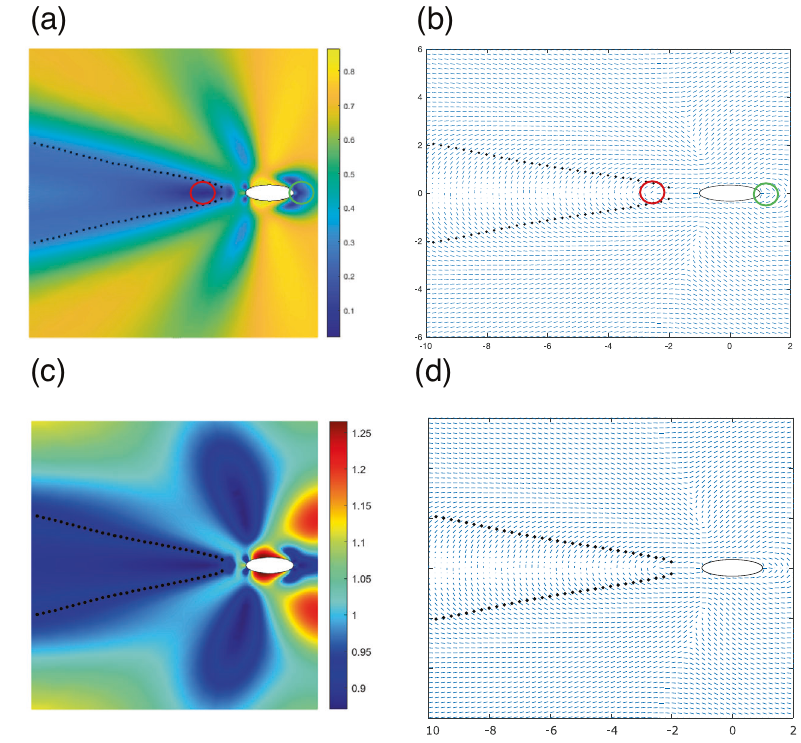
Fig. 4 Single swimmer in VELC. A single pusher ( β = − 2) with planar anchoring ( W = 0.5) in VELC. Coupling parameter χ = − 0.01. Topological defects generated by the swimmer are encircled. Red and green circles are correspondingly “ + 1/2 ” and “ − 1/2 ” defects. The dashed lines shows a transient tunnel formed by the swimmer. a Scalar order parameter q ( x ) around the swimmer. b Director fi eld n ( x ) around the swimmer. c Largest eigenvalue of conformation tensor C. d The eigenvector corresponding to the largest eigenvalue of